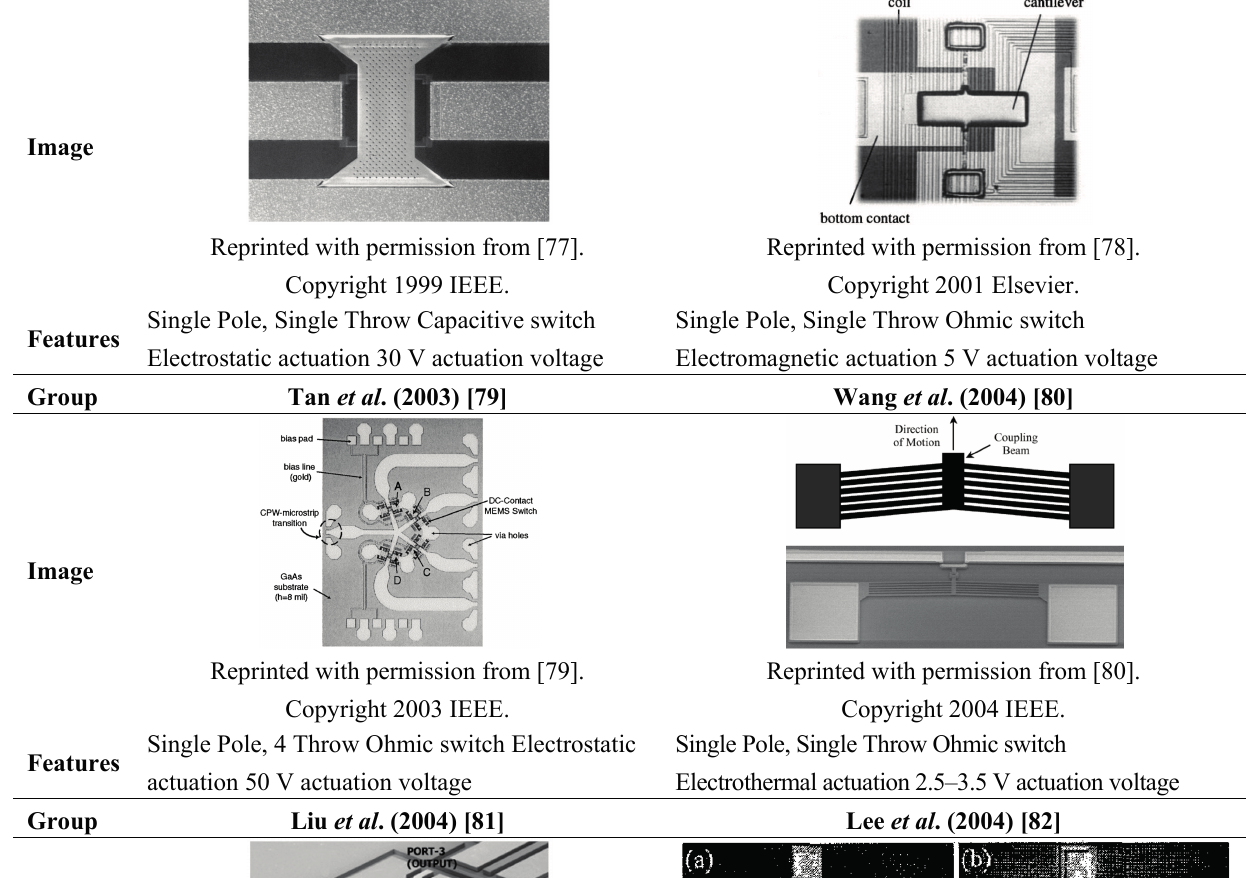
Table 2. Comparison table of MEMS switches reported in the literature.